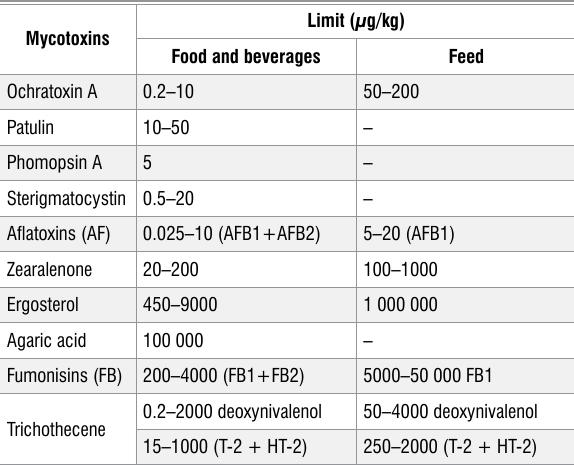
Recommended maximum limits of mycotoxins in food and feed in Mozambique Mycotoxins